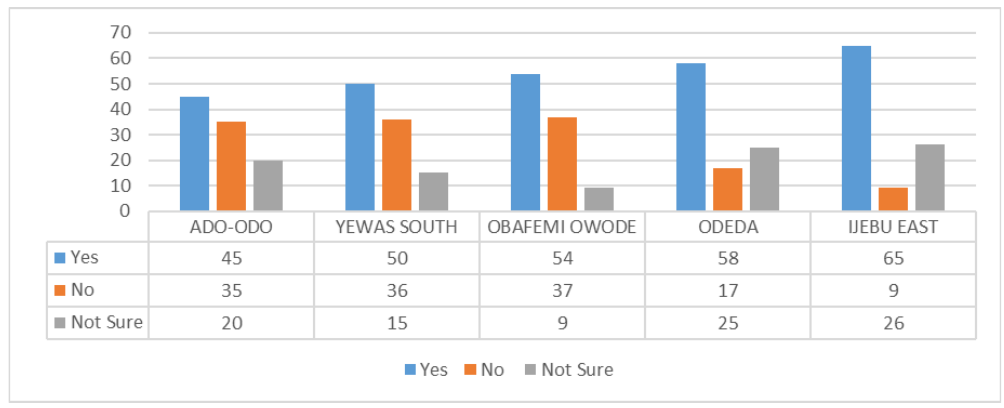
Figure 6. Responses on willingness to participate in any SWM improvement initiative.